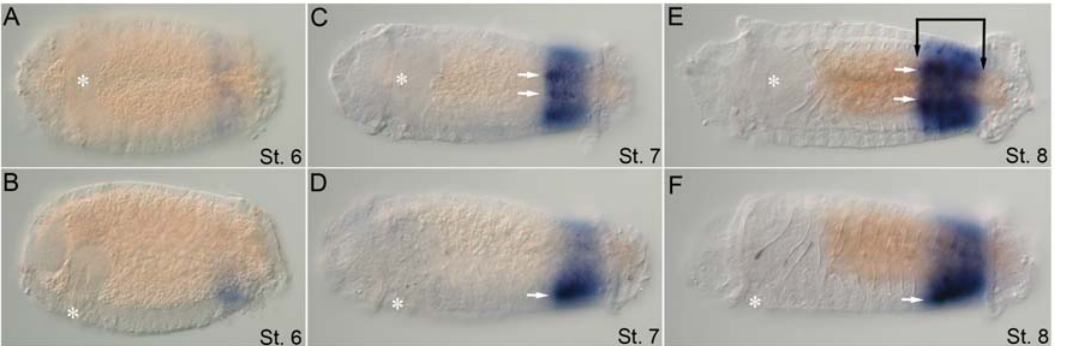
Figure 11. Larval expression of CapI-lox2 . Anterior is to the left for all panels. Stages are written at the bottom right of each panel. (A), (C), and (E) show ventral views; (B), (D), and (F), lateral views with ventral down. The position of the mouth is marked by an asterisk. (A, B) CapI-lox2 expression is in the ventral and ventrolateral part of the ectoderm of the abdominal segments during stage 6. (C, D) By stage 7, expression in the VNC (white arrows) and ventral and lateral epidermis extends from A1 to the growth zone. (E, F) CapI-lox2 expression at stage 8 includes ectodermal expression in A1 to A4 and the growth zone (black bracket). doi:10.1371/journal.pone.0004004.g011 growth zone (Figure 11C and 11D). Over time, expression expands into newly formed segments, including all abdominal segments formed during larval stages (A1–A4; Figure 11E and 11F). CapI-lox2 expression is absent from the dorsal midline.